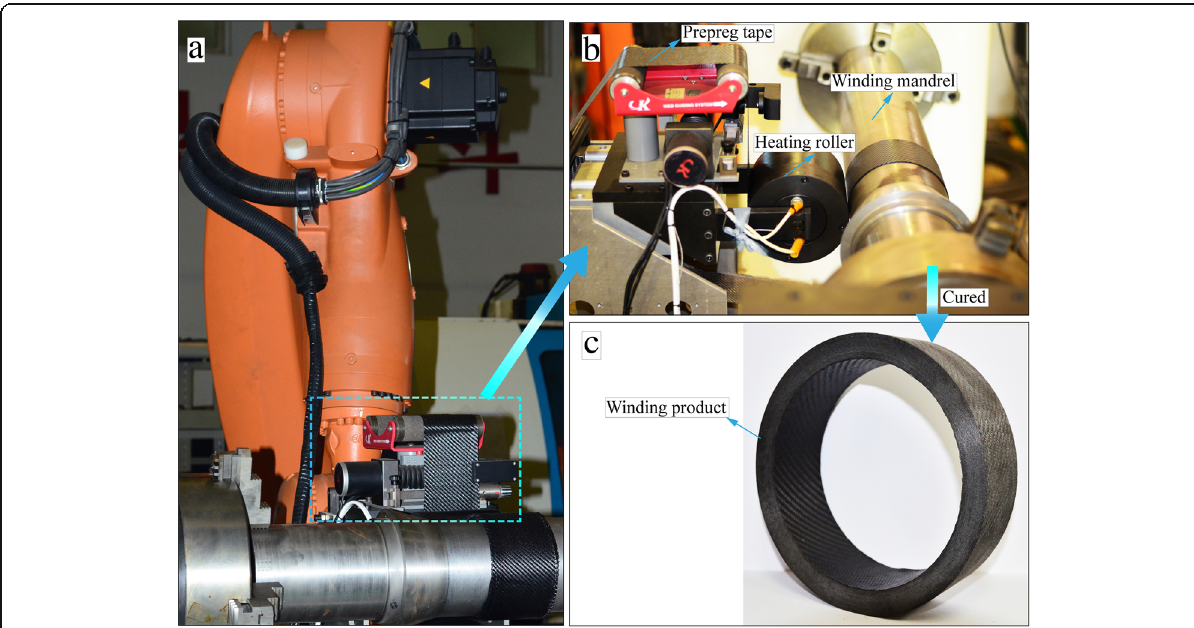
Fig. 2 Automate tape winding KUKA robot (XGD-1200). a Mechanical arm of XGD-1200. b Tape winding head. c Cured winding